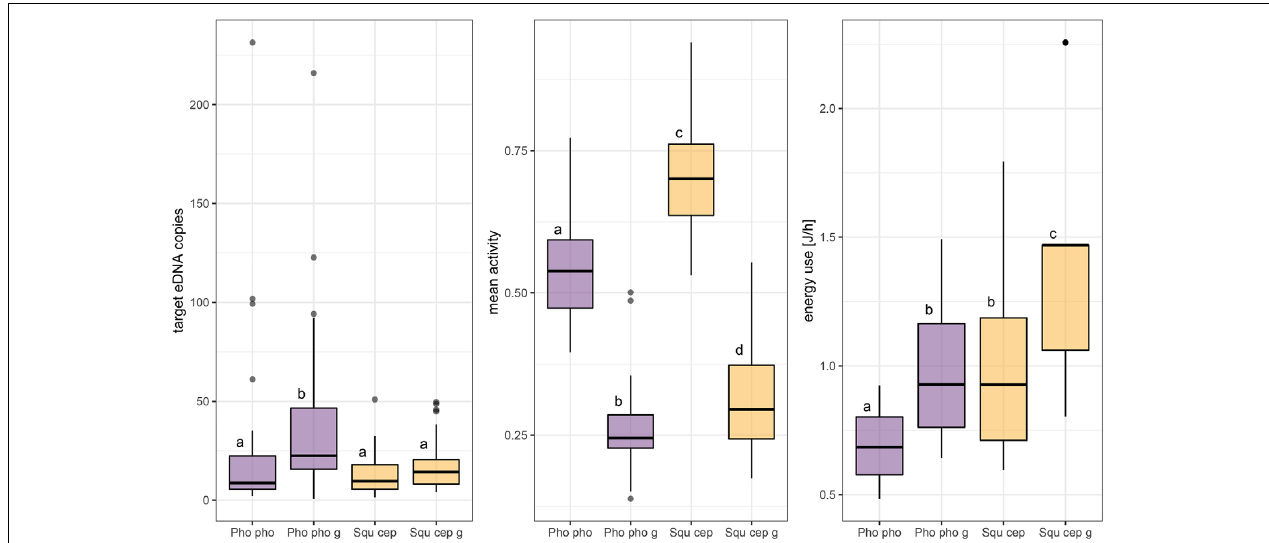
FIGURE 5 | Comparison of target eDNA copies, mean activity, and energy use (normalized by fish mass) in aquaria obtained from single and grouped individuals of Phoxinus phoxinus and Squalius cephalus . Different lower case letters above boxplots code for significant differences ( p < 0.05) between categories, which are abbreviated as: “Pho pho,” Phoxinus phoxinus (single fish); “Pho pho g,” Phoxinus phoxinus grouped fish; “Squ cep,” Squalius cephalus (single fish); “Squ cep g,” Squalius cephalus grouped fish.